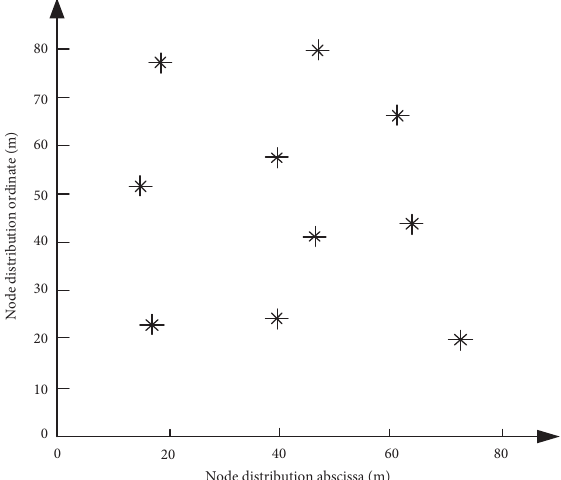
Figure 16: Experimental results of node initialization performance of traditional methods.